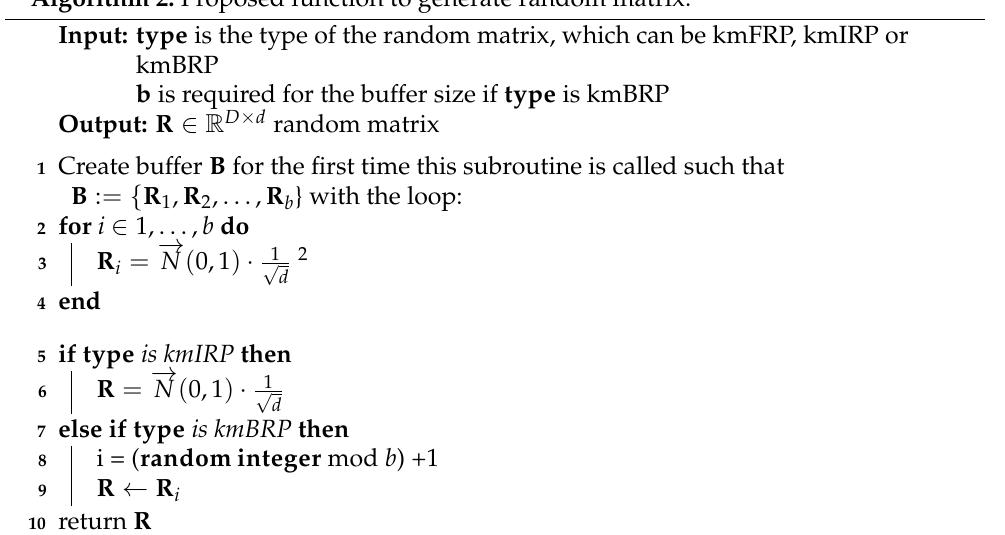
Algorithm 2: Proposed function to generate random